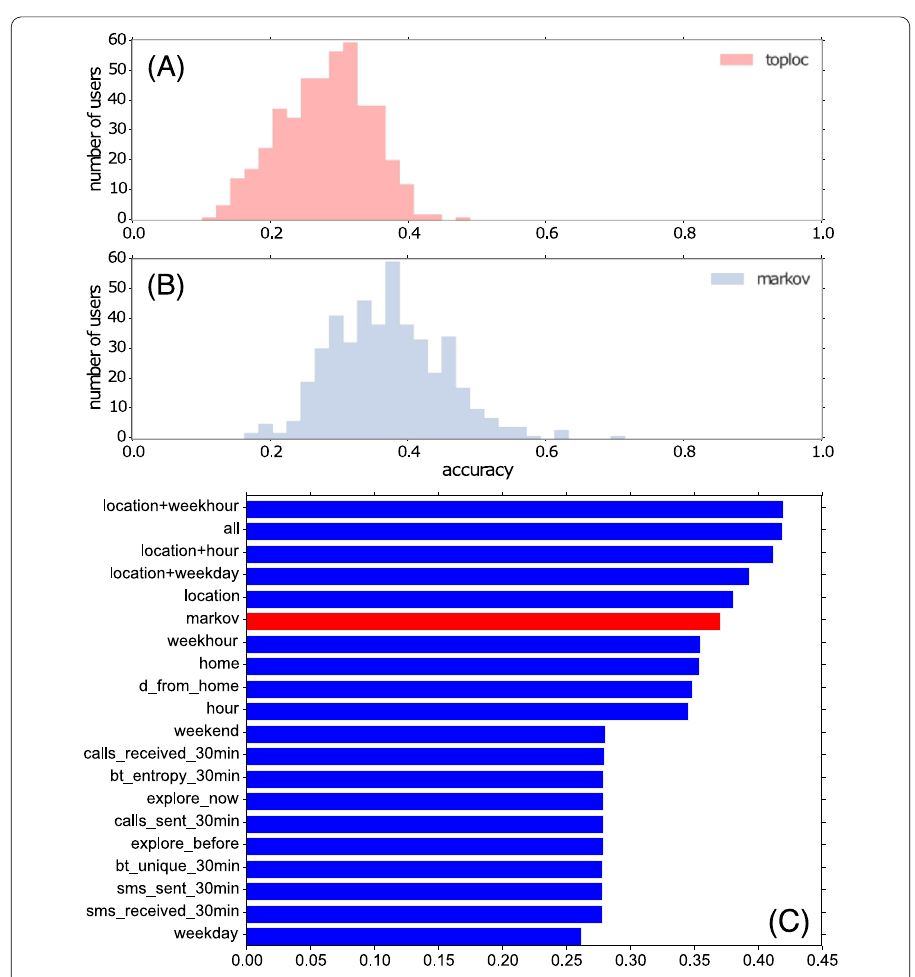
Figure 5 (A) Accuracy for the toploc model in the next-place formulation. (B) Accuracy for the Markov model in the next-place formulation. (C) Summary of next-place prediction accuracy for all logistic regression models. The location and time-related features are the most predictive ones, and outperform the Markov model